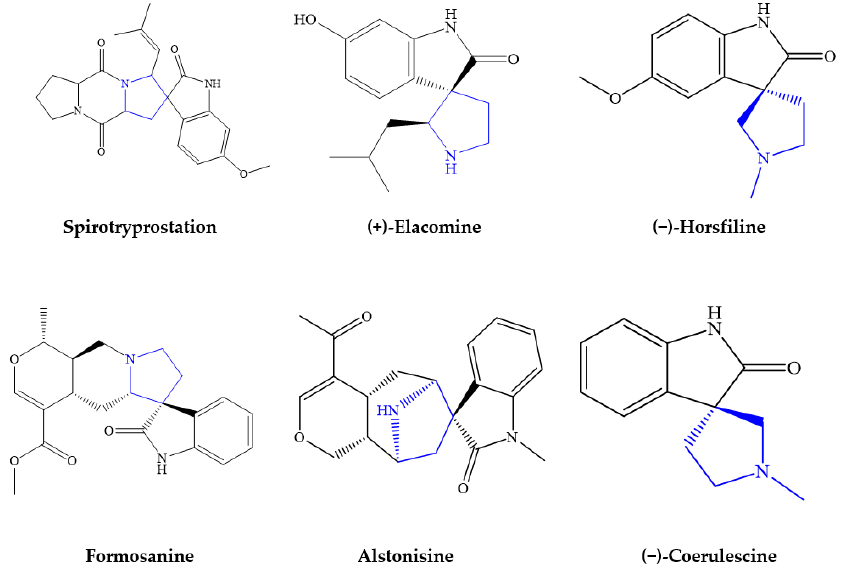
Figure 1. Highly pronounced biological spiropyrrolidine derivatives.